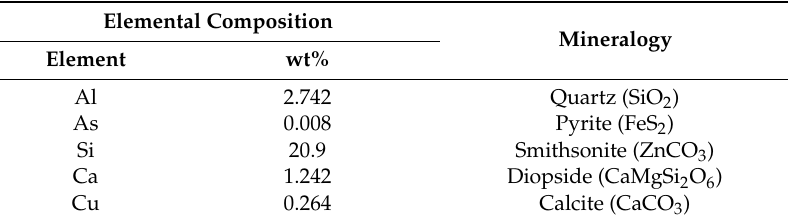
Table 1. Main chemical and mineralogical composition of the tailings. Elemental